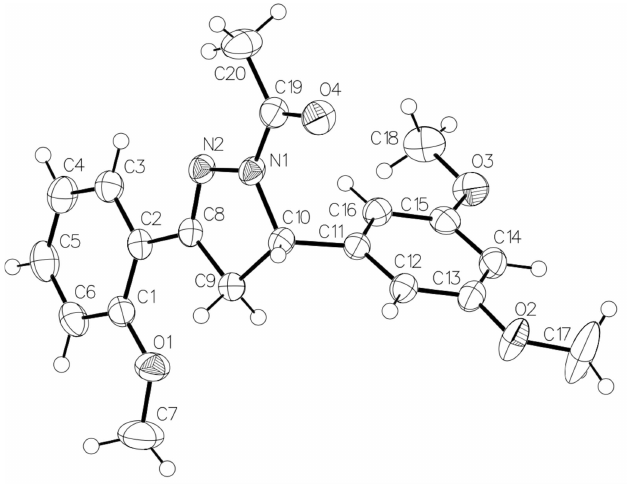
Figure 1 The molecular structure of the title compound, showing the atom- labelling scheme, with displacement ellipsoids drawn at the 30% probability level.